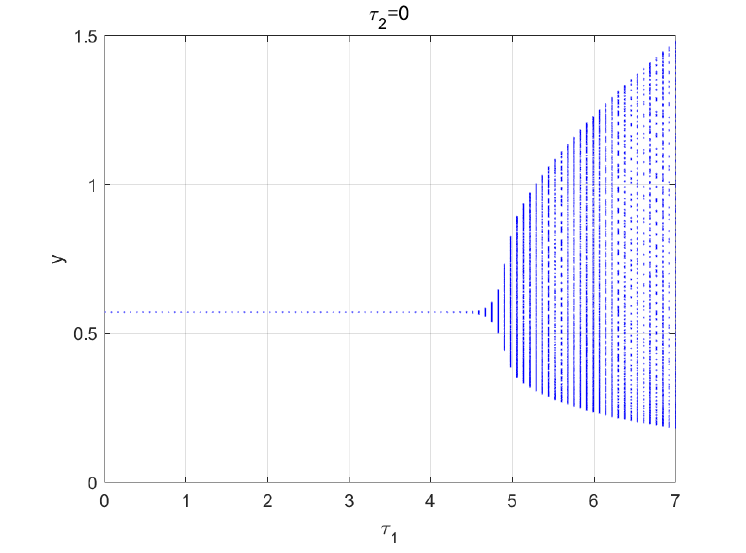
Figure 3. ( a ) Time series and ( b ) phase portrait of E ∗ for system (1) when τ 1 = 5 and τ 2 = 0. Other parameters are same as in (32).